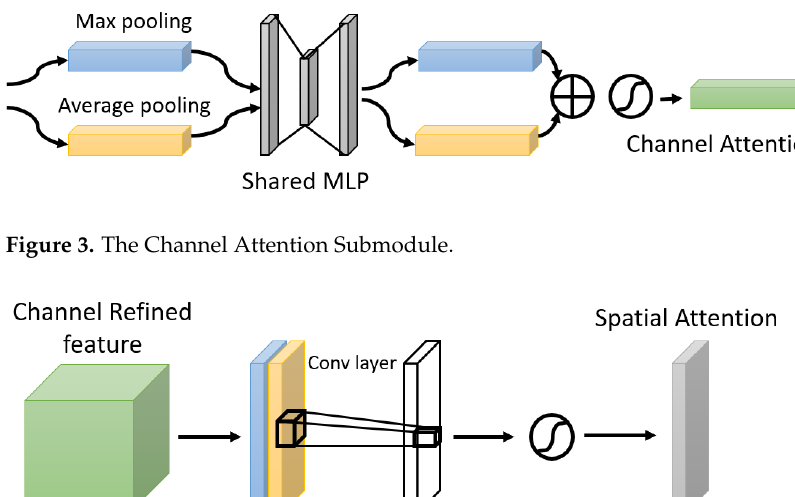
Figure 2. The Convolutional Block Attention Module (CBAM).